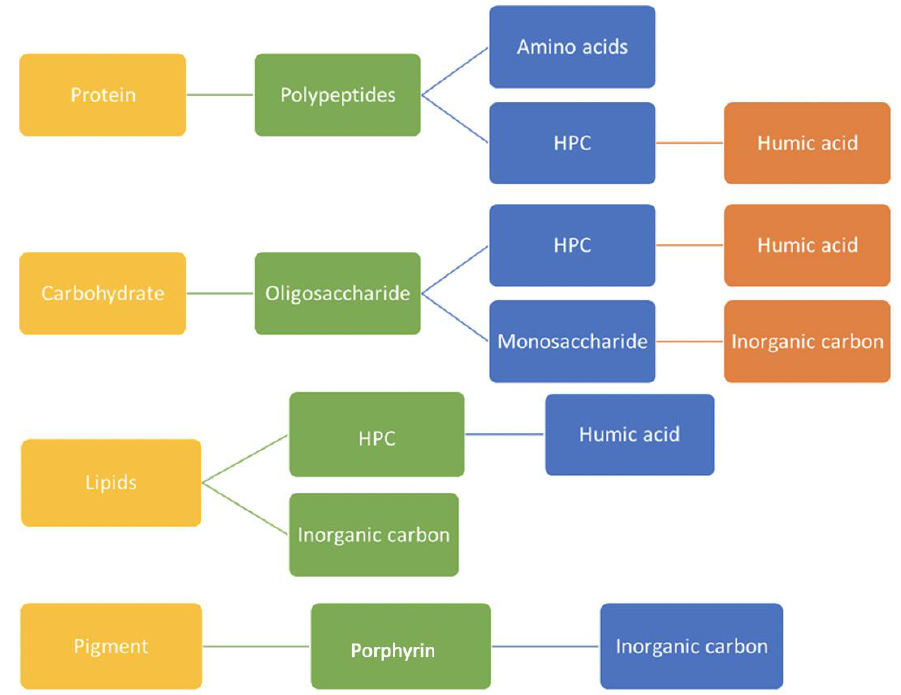
Figure 1. A box diagram of organic biopolymer and macromolecular group interconnections in the nodal river model. In the interest of brevity, we omit the biomarkers and apportionment of the overall chromophoric content, the latter including small fractions of several other classes plus 100% chlorophyll/pigments.